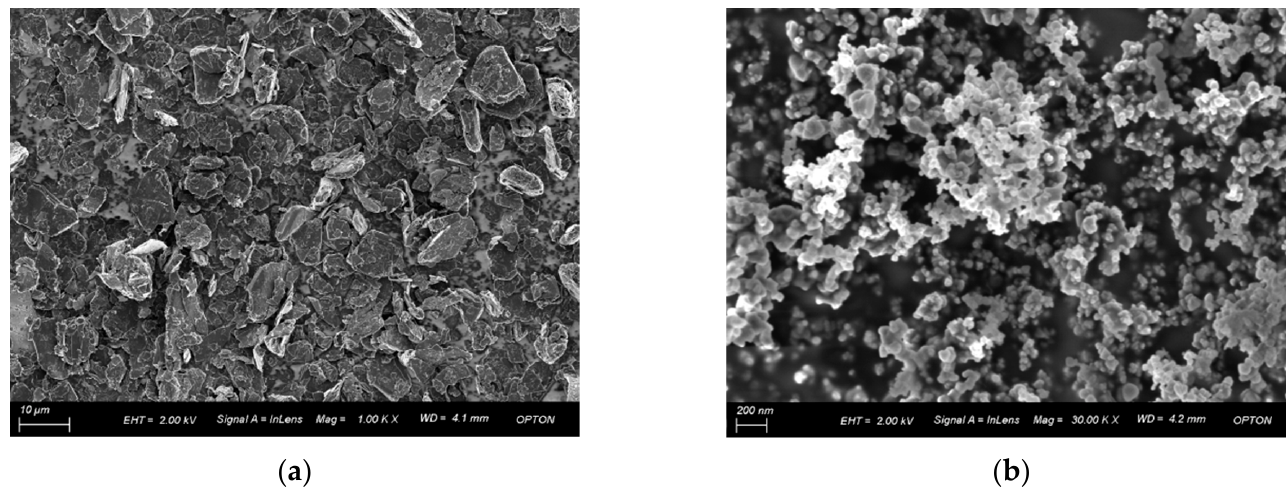
Figure 3. SEM morphology of graphite sheet and SiC nanoparticles. ( a ) Graphite sheet; ( b ) SiC nanoparticles.